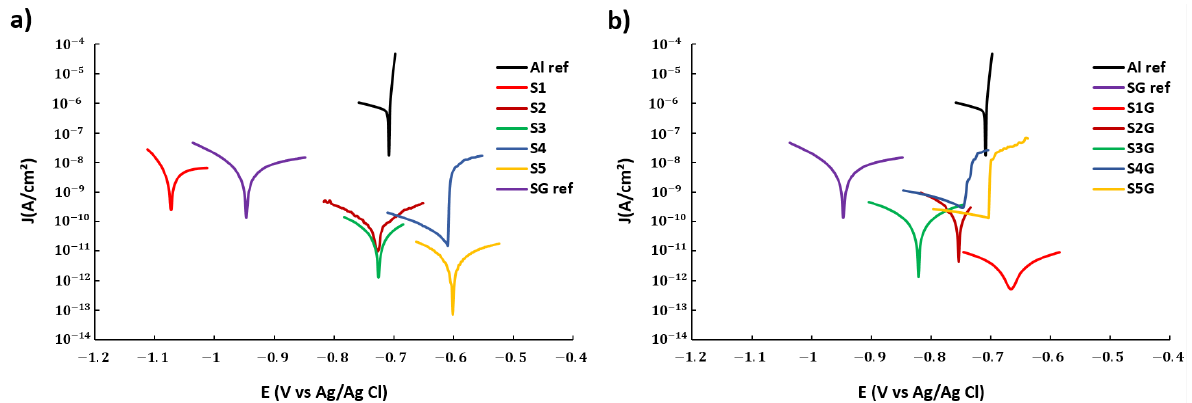
Figure 15. Tafel plots corresponding to the aluminum bare substrate and the different aluminum samples composed of PVDF-HFP electrospun fibers mats without ( a ) and with ( b ) glue layer after being tested in 6 wt% NaCl aqueous solution. For greater clarity, only the interval ±100 mV is shown in each curve.